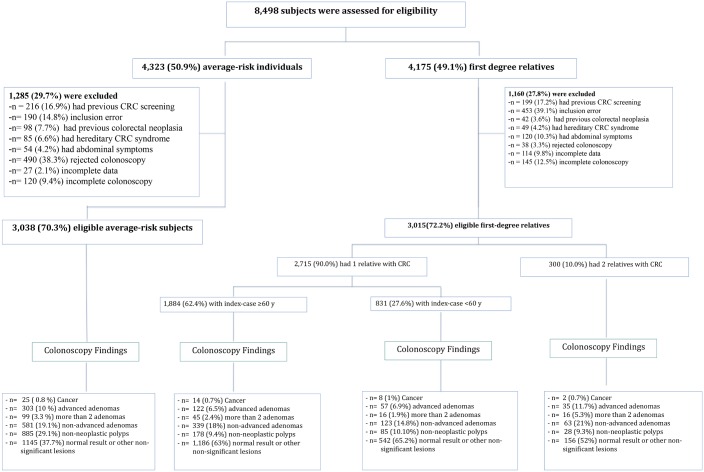
Study enrollment and outcomes.Asymptomatic average-risk individuals and familial-risk individuals undergoing their first lifetime screening colonoscopy were prospectively included in the six participating centers. All had high-quality colonoscopies (good or excellent bowel cleansing and cecal intubation).